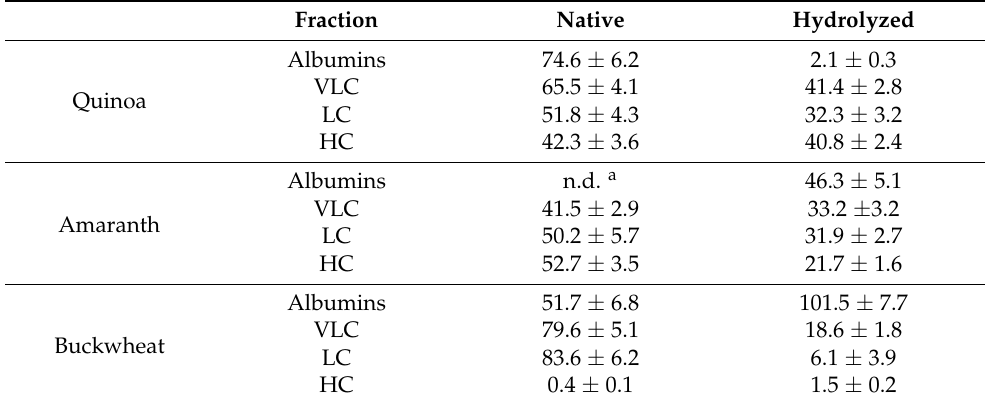
Table 2. Trypsin inhibition percentage of protein fractions as such (native) and following simulated gastro-intestinal digestion